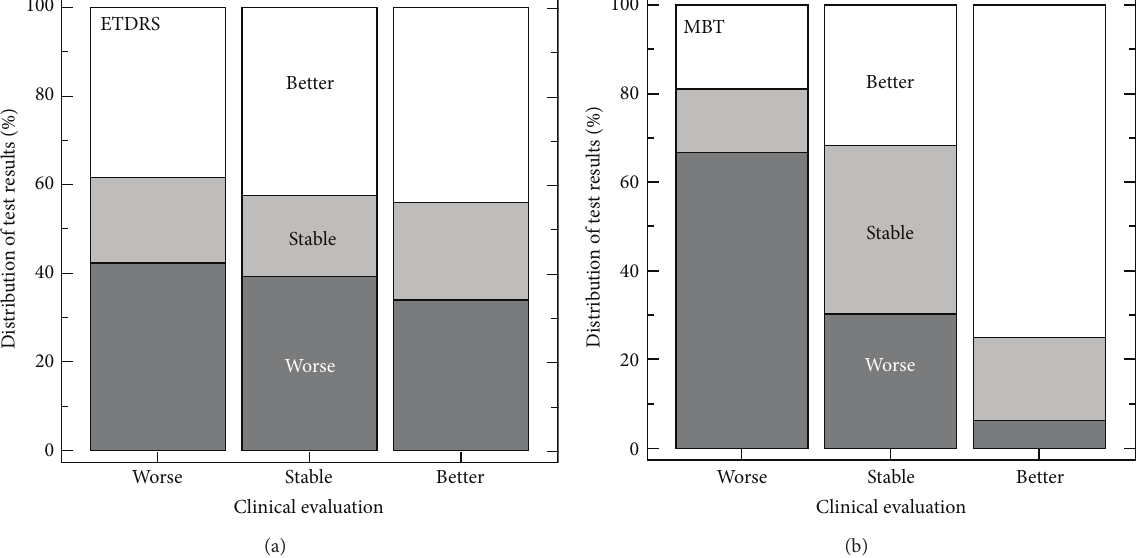
Figure 5: Distributions of clinical versus vision test ratings for 144 follow-up epochs. (a) ETDRS, (b)